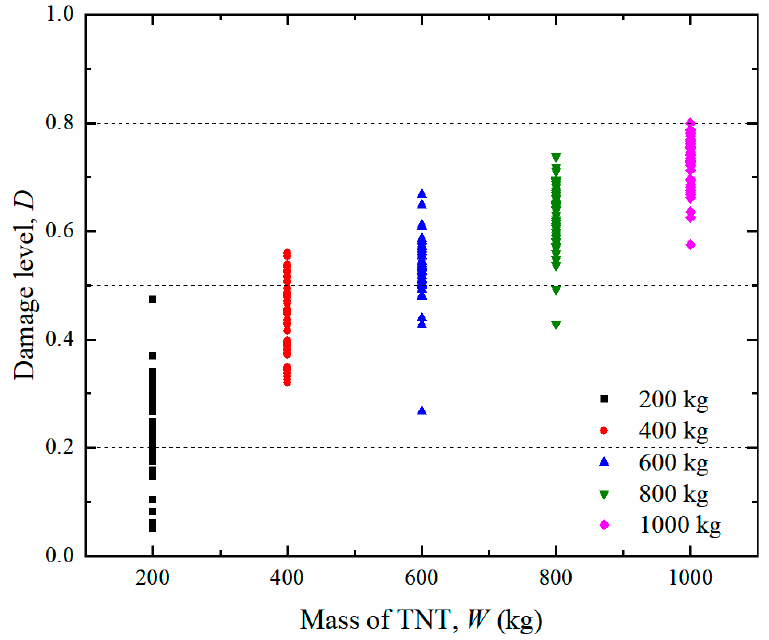
Figure 15. Sample data distribution of W and D .